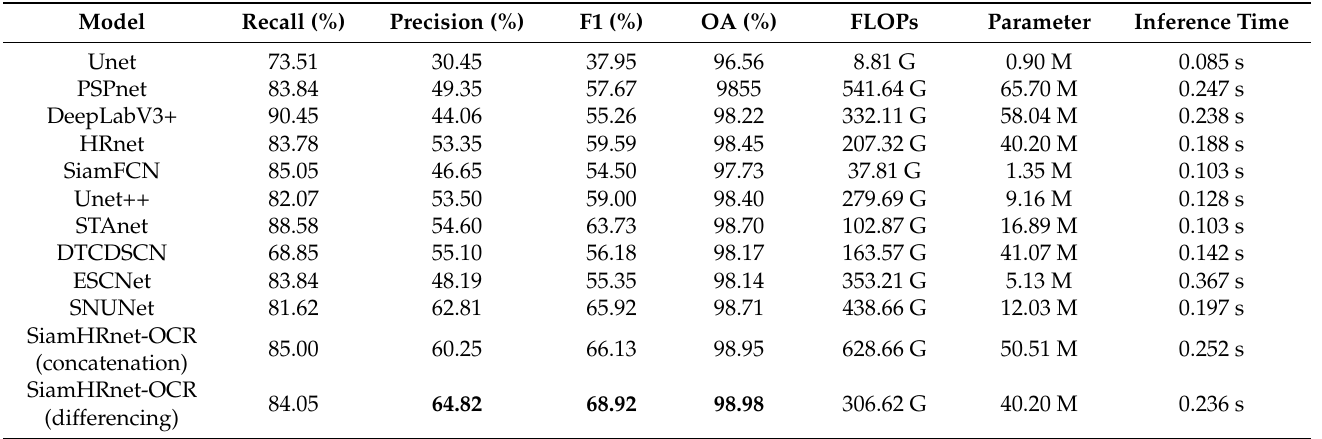
Table 11. Model comparison (The FLOPs, Parameter, and Inference time are calculated on two